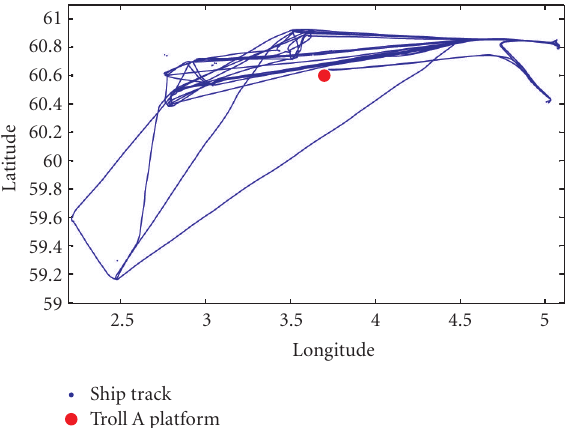
Figure 29: Ship tracks and Troll A platform position for the month of January 2010.